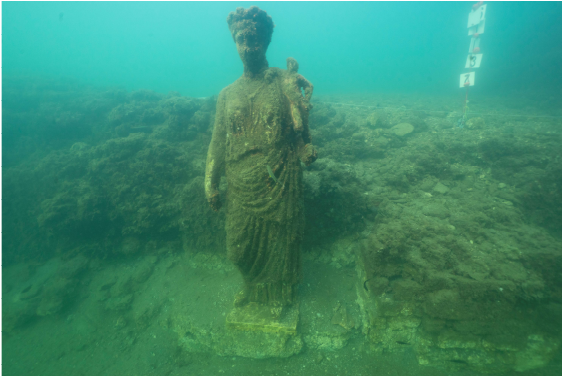
Figure 4 (a). Raw picture before image enhancement.